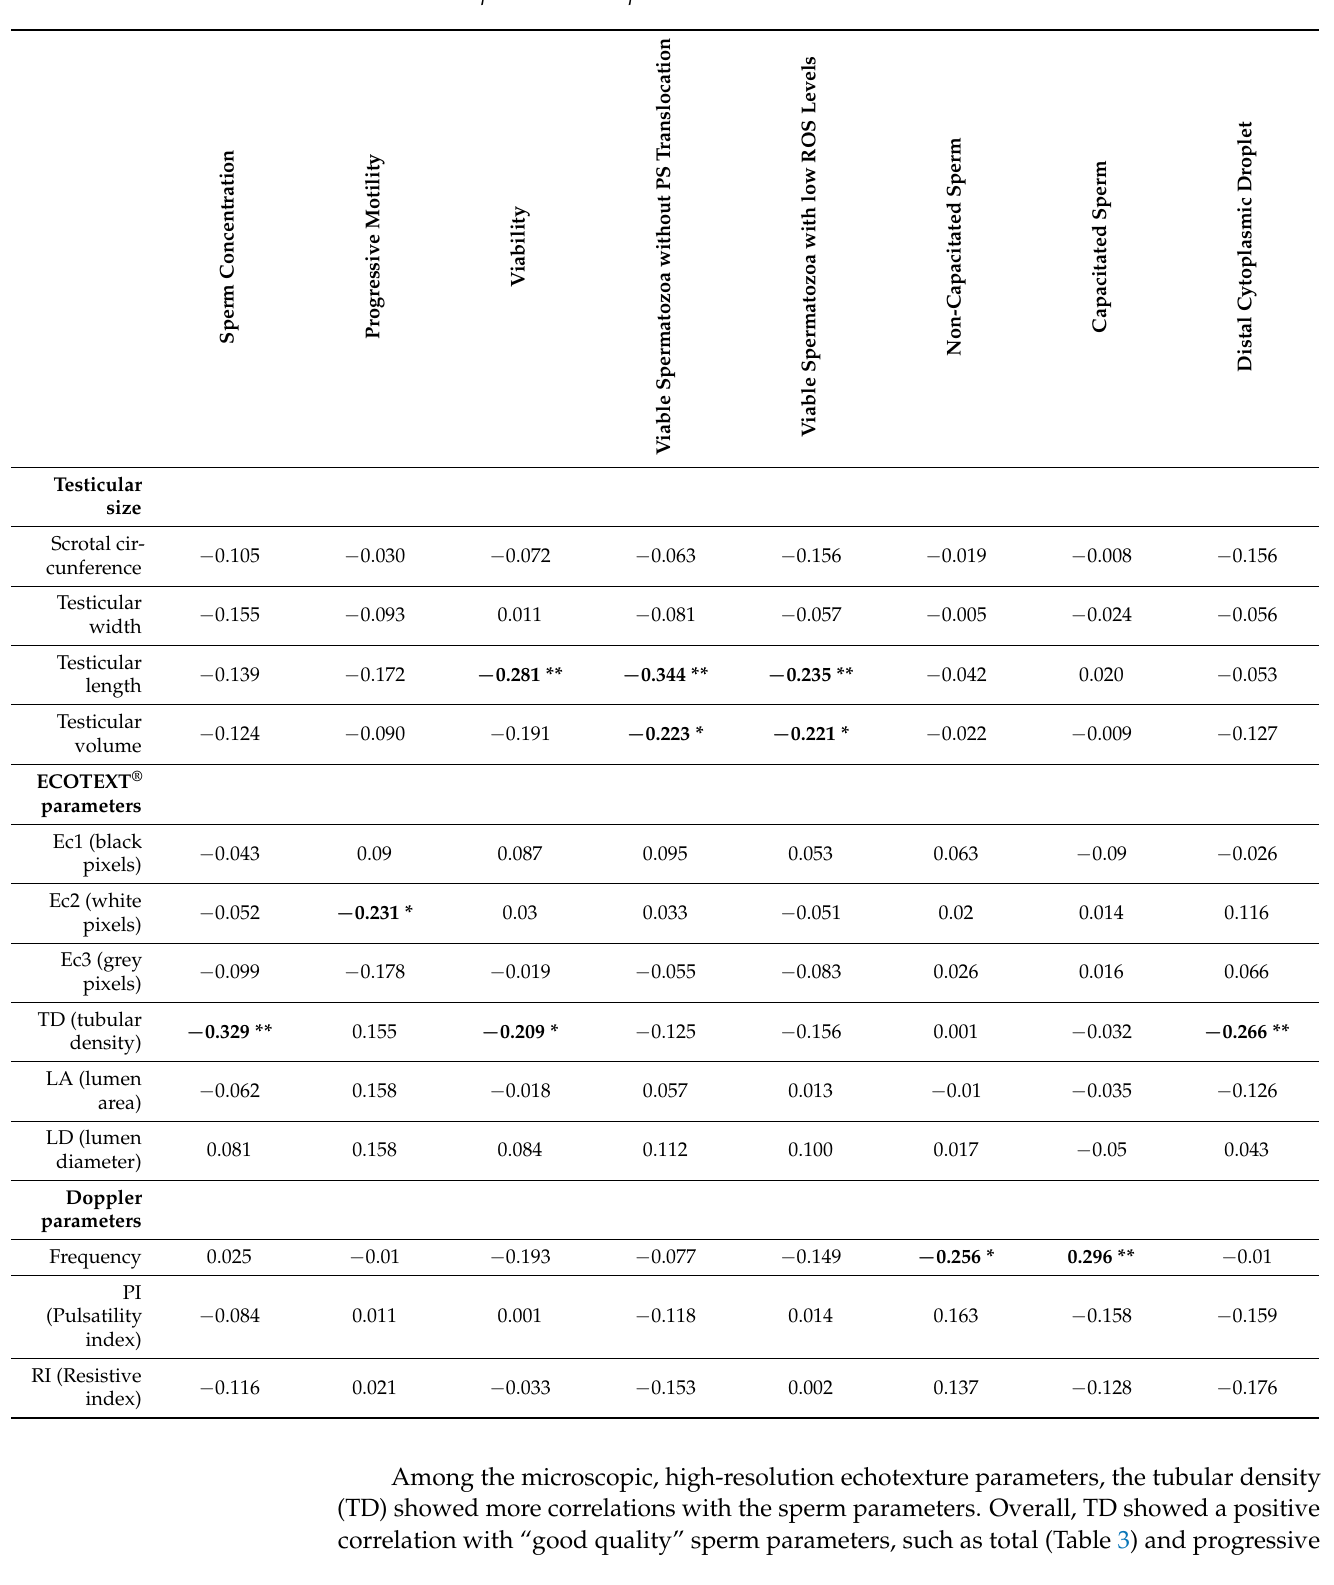
Table 5. Spearman’s rank correlation coefficient (Spearman’s ρ ) between testicular size, echotexture parameters (evaluated by ultrasound-video analysis and ECOTEXT ® software) or testicular-artery blood flow (assessed by color-Doppler flow imaging) and some sperm parameters, analyzed 60 days after the testes evaluation, in Rasa Aragonesa rams ( n = 96). Bold type indicates statistically significant correlations. * p < 0.05 and ** p <